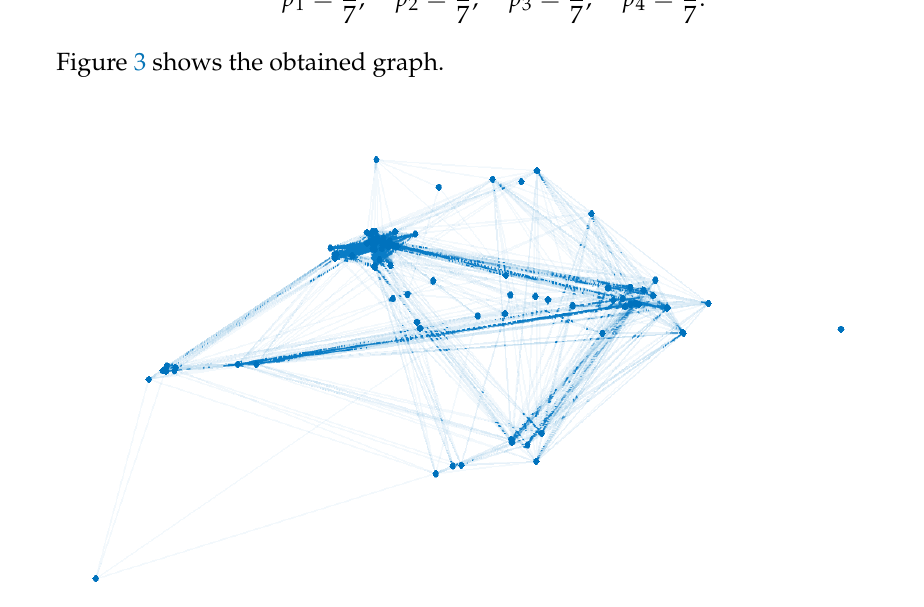
Figure 3. Graph obtained from database of Olmué city, Chile, with 3866 vertices and 6,841,470